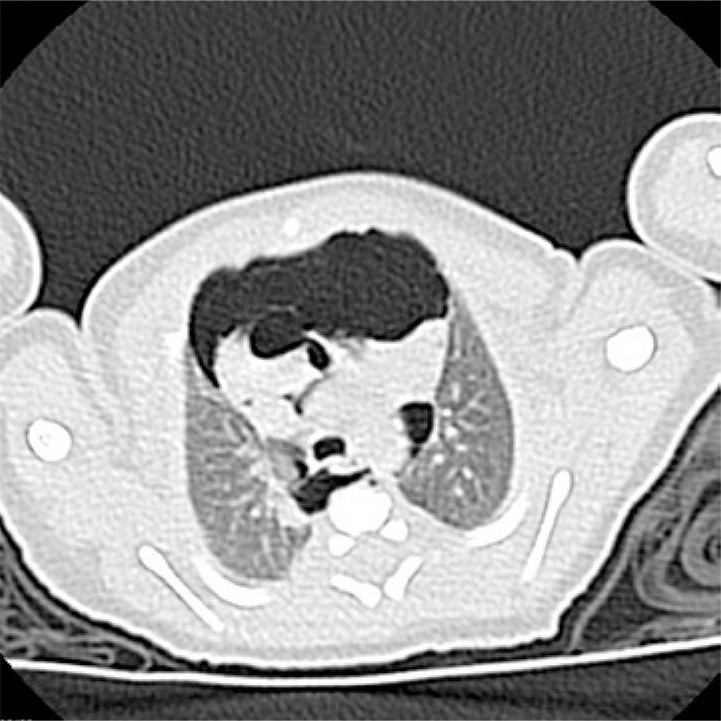
Tomografia computorizada que mostra extenso pneumomediastino com discreta septação, sem alterações do parênquima pulmonar (corte transversal)